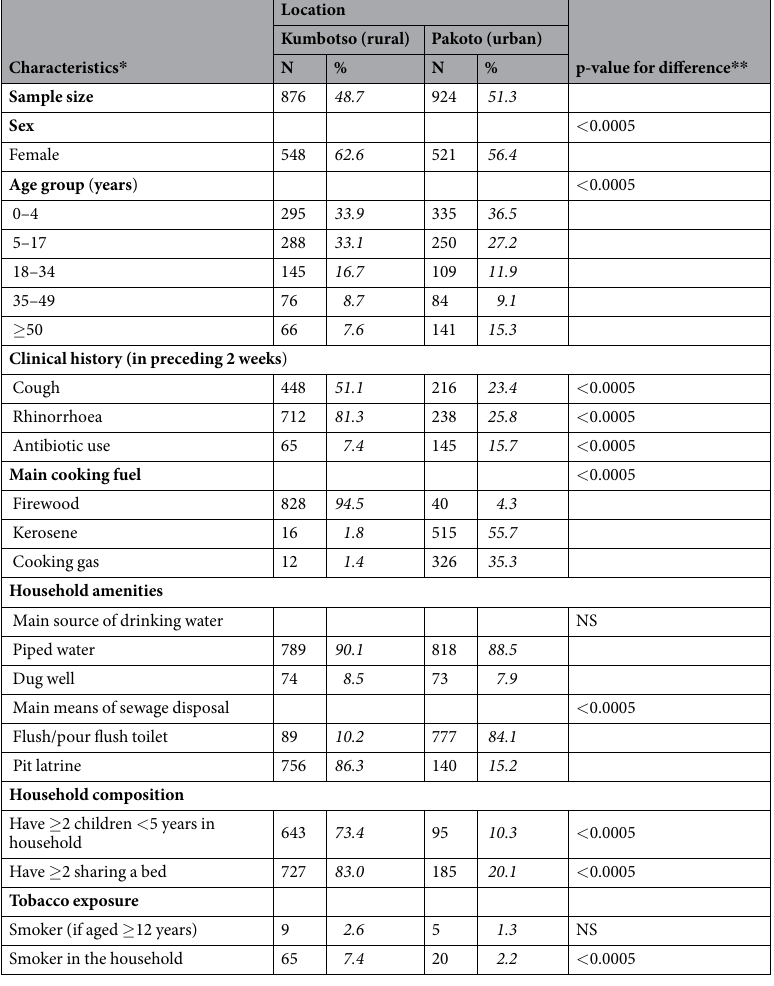
Table 1. General Characteristics of the Nigerian pneumococcal carriage survey population. * Subtotals for characteristics may not add up to N on account of missing data. ** p-values are for differences in group-level characteristics between locations unless individual level values are provided.